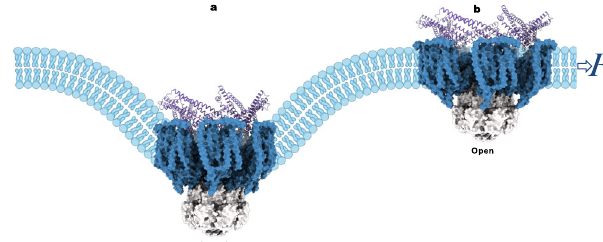
Fig. 6 | Model for MscK gating. a , b MscK in the closed, resting ( a ) and open, conductive ( b ) states depicted in a lipid bilayer. Membrane curvature induced by the TMDisindicated( a ).Membrane tension drivesthe fl attening and expansion of theTMDnecessaryfortheopeningofthetransmembranepore.Thisgatingprocess is additionally regulated by the periplasmic gating ring, which may sense external ionic conditions. The cytoplasmic (gray), transmembrane (blue), and periplasmic (purple) domains are individually